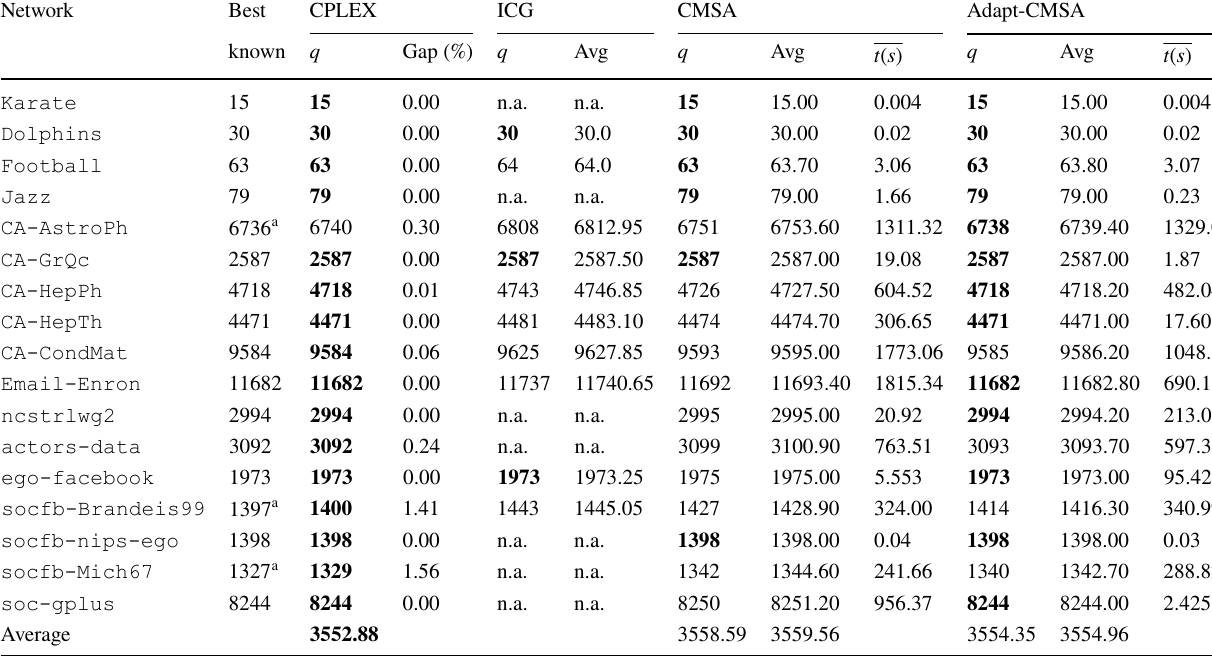
Table 1 Numerical results for small to medium size instances